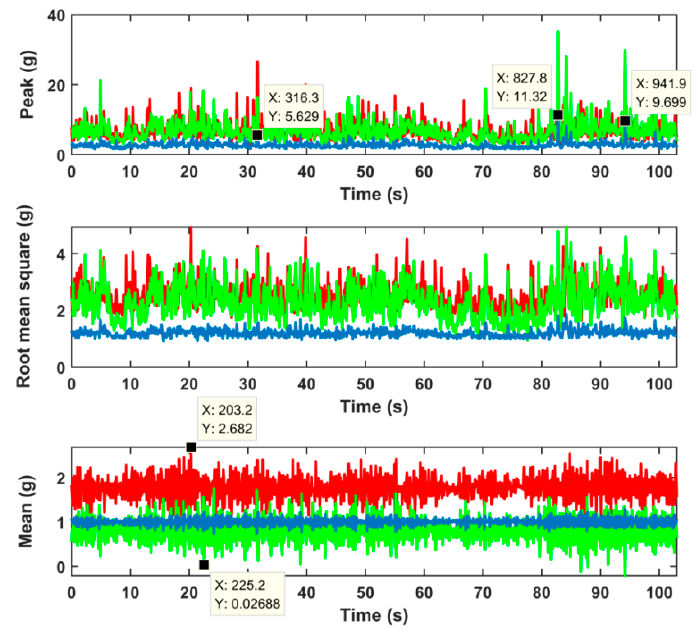
Figure 8. The peak value, root mean square value, and mean value curve of the time domain signal intercepted from the 4740~4750-m section according to a time window with a length 100 of signal points.